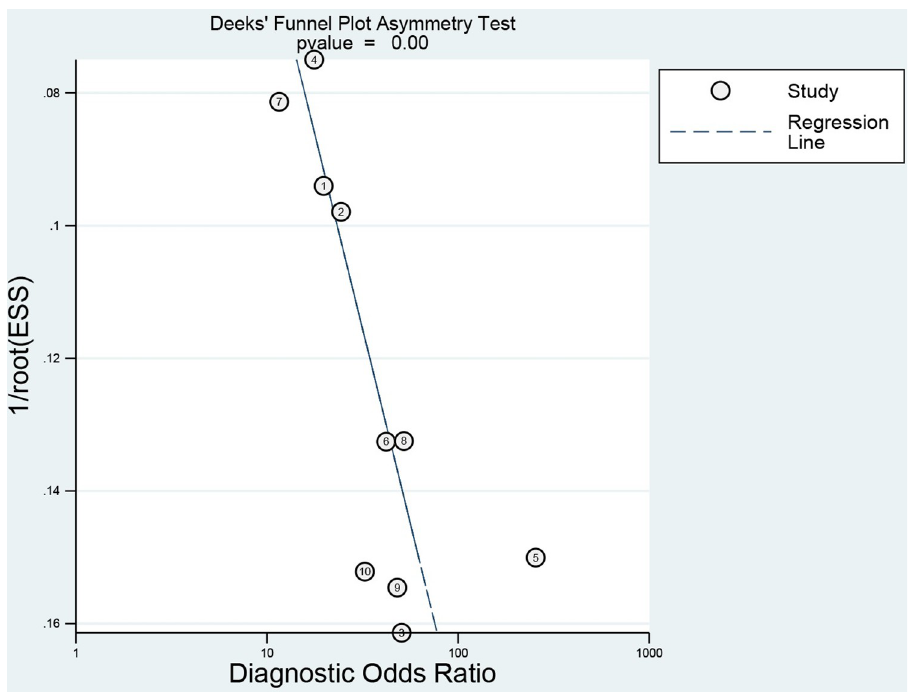
Fig 6. Deeks publication bias test.